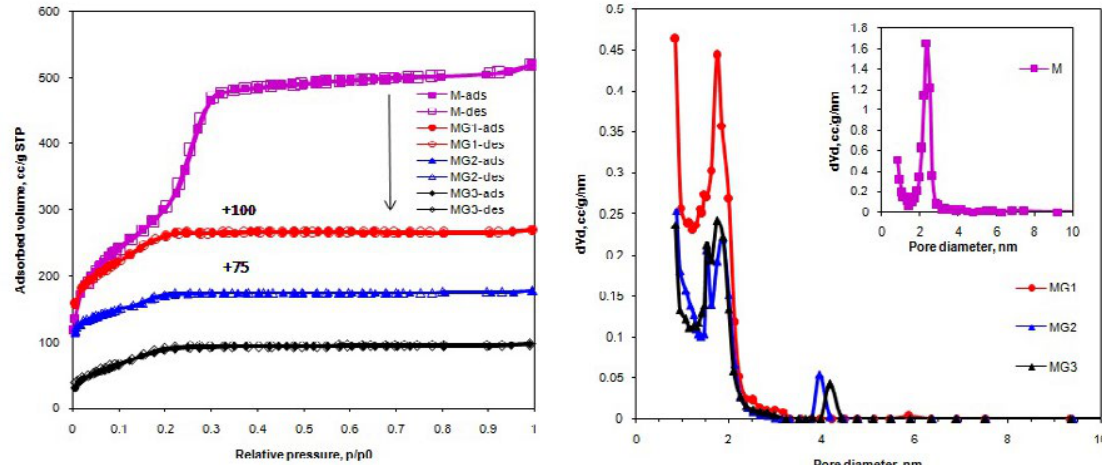
Figure 3. Nitrogen adsorption isotherms for pure and amino-functionalized silica samples MG